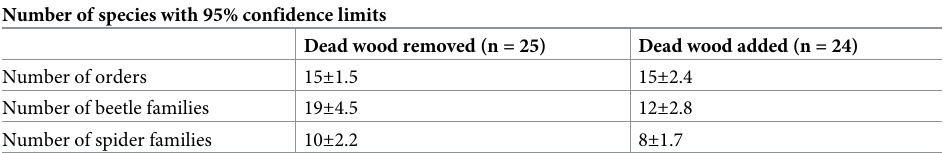
Table 1. Rarefaction analyses output. The number of observed taxa with 95% confidence limit, for number of orders, beetle families and spider families when dead wood was either added or removed.